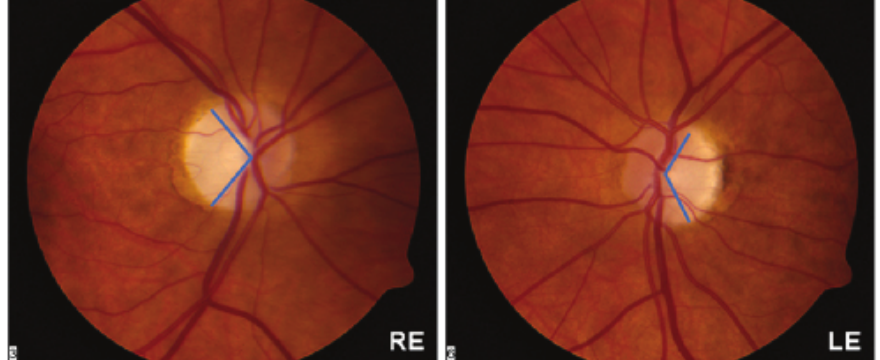
Figure 2. Temporal pallor seen in dominant optic atrophy. Both eyes optic disc photograph (RE – right eye, LE – left eye) showing temporal pallor with loss of fine capillary network in a case of Dominant Optic Atrophy with OPA1 mutations.